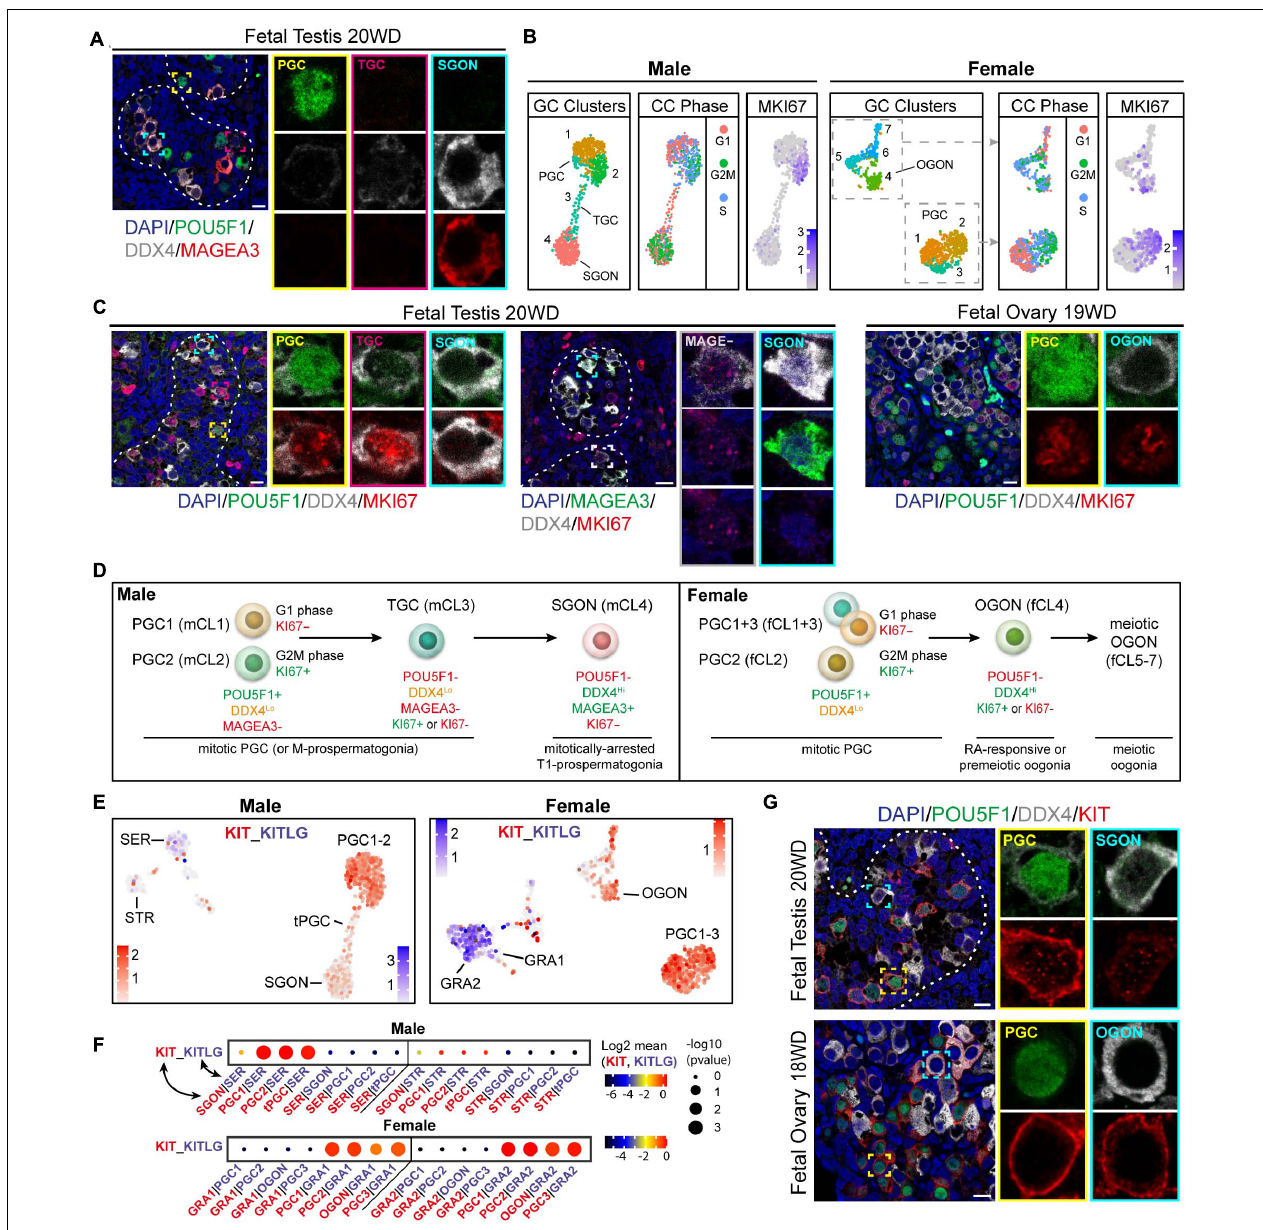
FIGURE 2 | Characterization of germ cell proliferative state and validation of the receptor–ligand analysis method. (A) Immunofluorescence of MAGEA3, POU5F1, and DDX4 in fetal testis (18 WD), revealing three germ cell types: POU5F1 + /DDX4 low /MAGEA4 − primordial germ cells (PGCs), POU5F1 − /DDX4 high /MAGEA4 + SGON, and POU5F1 − /DDX4 low /MAGEA4 − transitory germ cells (TGCs). (B) UMAP visualization of isolated male (left panels) and female (right panels) germ cell (GC) clusters, showing cluster identification, estimated cell cycle (CC) phase, and MKI67 expression. Both male and female PGC show variable CC state and expression of MKI67, reflecting proliferation. However, gonia (GONs) differ between male and female, with MKI67 being expressed in oogonia (OGONs), but not in prospermatogonia (SGONs). (C) Immunofluorescence of MKI67 in fetal testis (18 WD) and ovary (19 WD). A subset of PGCs (POU5F1+) and TGCs (POU5F1 − /DDX4 low ) shows positive MKI67 staining, whereas SGONs (left panel: POU5F1 − /DDX4 Hi , middle panel: MAGEA3 + /DDX4 Hi ) were never MKI67 positive. In fetal ovary, both PGC and premeiotic OGONs MKI67 + subsets are present. (D) Overview of identified germ cell subtypes, the markers used for their identification, and their proliferative state. (E) UMAP plots of male and female sets showing expression levels of KIT (in red) and KITLG (in blue). KIT is expressed in PGC clusters and premeiotic OGONs, while KITLG is expressed by GRA1–2 and Sertoli cells (SER). (F) CellphoneDB analysis of KIT–KITLG interaction between different clusters in male (top) and female (bottom) fetal gonads. Depicted are − log 10 p -values (circle size) and log 2 means (circle color) for the KIT–KITLG interacting pair, for selected pairwise cluster combinations. In the ovary, a significant KIT–KITLG interaction is observed from GRA to PGC and OGON clusters, while in males, a significant interaction is observed from SER to PGC clusters only. (G) Immunofluorescence of KIT with POU5F1 and DDX4, in PGCs (POU5F1 + ) and GON (POU5F1-) in fetal testis (20 WD) and ovary (18 WD). Consistent with scRNA-seq data, KIT is expressed by PGCs and OGONs, but not SGONs. Yellow boxes indicate zoom-in of a PGC, and cyan boxes indicate zoom-in of a GON. Scale bar is 10 µ m.